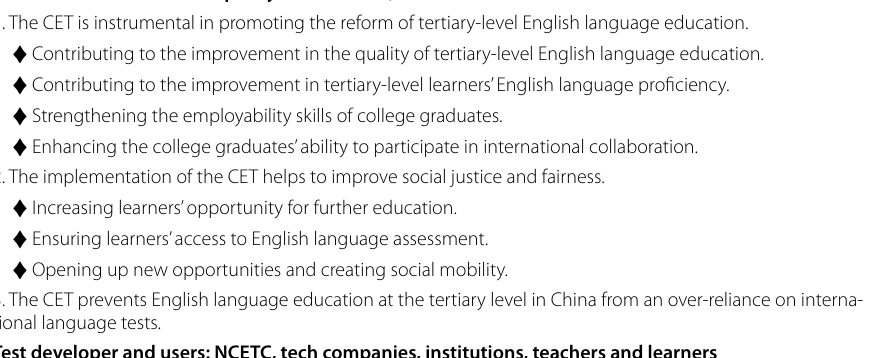
Table 1 Claims for the TOA argument of CET consequences Education and assessment policymakers: MOE,